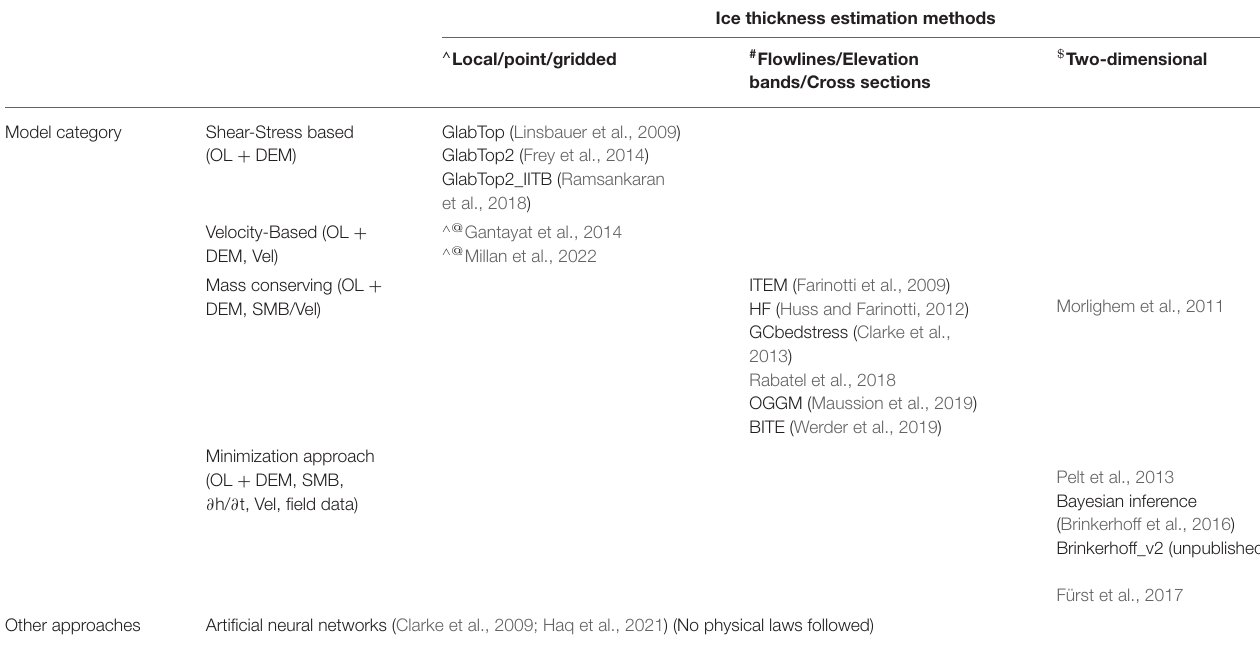
TABLE 4 | List of model categories and mode of estimating ice thickness. Brackets within the model categories represent the remote sensing-based inputs used in the